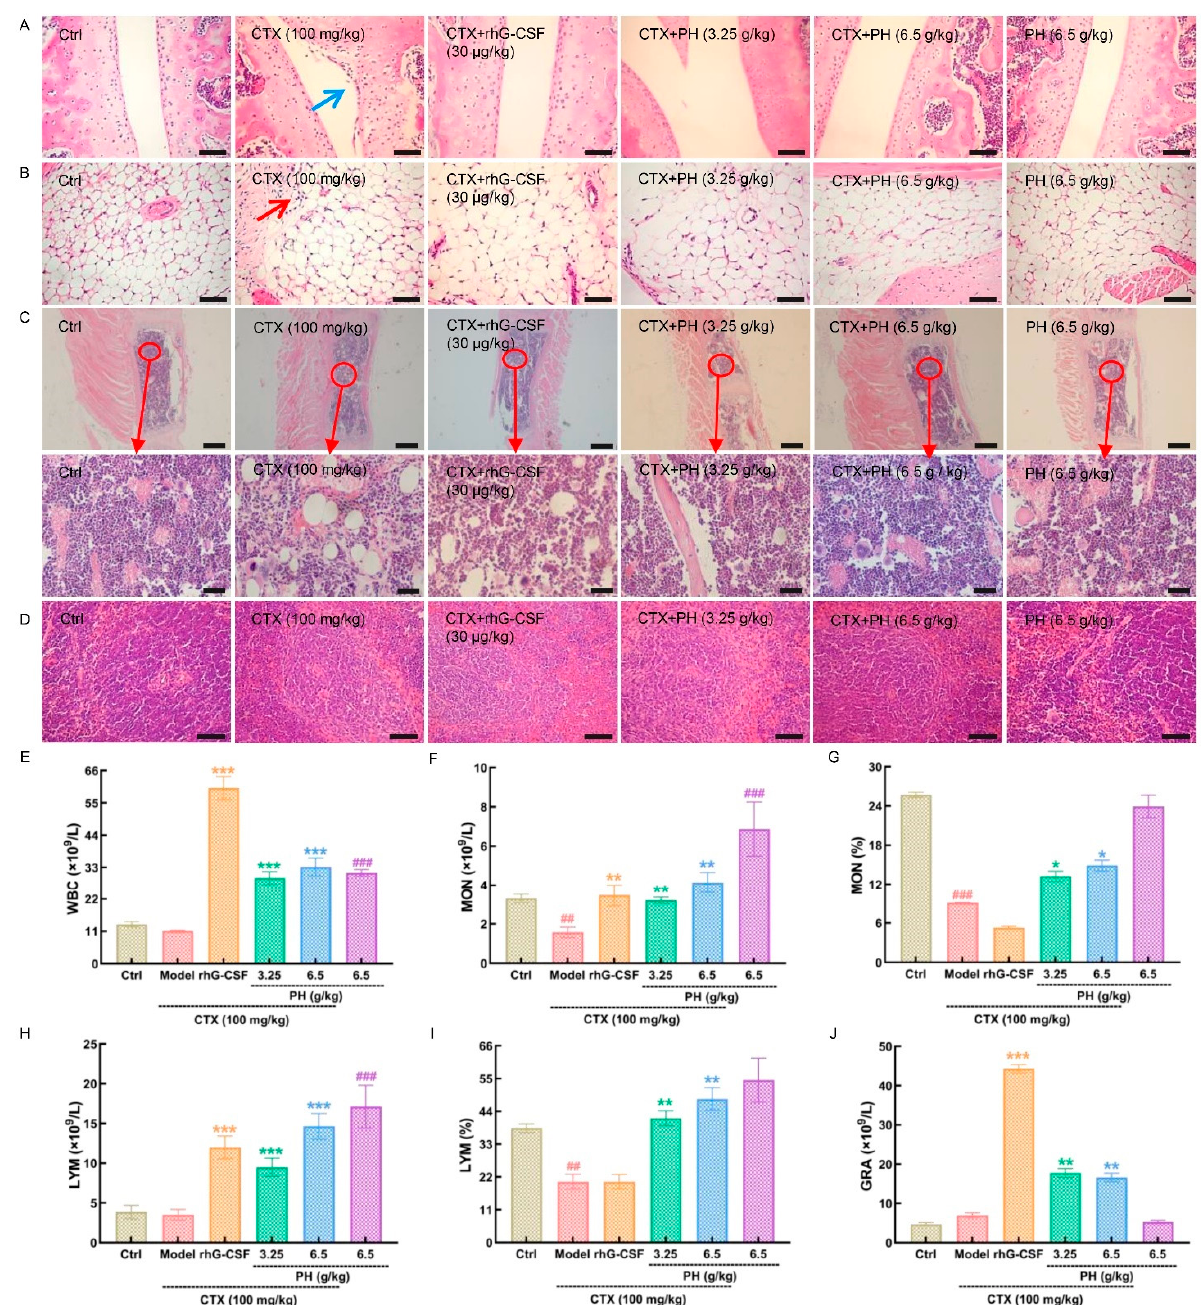
Figure 1. The protection effect of PH on CTX-induced mice with hematopoietic dysfunction. H&E staining was used to evaluate pathological alterations of ( A ) femoral condyle joint cavity (200 × , scale bar: 100 µ m), ( B ) joint circumference (200 × , scale bar: 100 µ m), ( C ) sternal marrow cavity (40 × , scale bar: 400 µ m; 400 × , scale bar: 40 µ m), and ( D ) spleen (200 × , scale bar: 100 µ m) under a light-microscope digital camera ( n = 3 mice/group in triplicate). Blue arrow in ( A ), a depression with inflammatory cell infiltration on the joint surface. Red arrow in ( B ), inflammatory cell infiltration can be seen in the tissue around the joint. PH regulated the levels of ( E ) WBC, ( F , G ) MON, ( H , I ) LYM, and ( J ) GRA in peripheral blood. Data are showed as the mean ± SD ( n = 5 mice/group in triplicate) and determined via a one-way ANOVA followed by a Tukey’s post hoc test comparison. ## p < 0.01 and ### p < 0.001 vs. control group, * p < 0.05, ** p < 0.01 and *** p < 0.001 vs. model group. CTX, cyclophosphamide; Ctrl, control; Model, hematopoietic dysfunction model; rhG-CSF, recombinant human granulocyte colony-stimulating factor; PH, Protein hydrolysate injection; WBC, white blood cell; LYM, lymphocytes; MON, monocytes; and GRA, granulocytes.